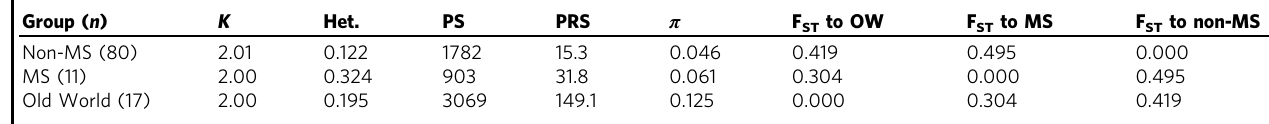
F ST between-group fi xationindex, Het. mean heterozygosity, K mean number of allelesperlocus, MS MatoGrosso Do Sul, n samplesize, non-MS NewWorld, excludingMS, PRS private sites,per sample, PS total polymorphic sites, π nucleotide diversity. HTZ and MIX genotypes are not used in this